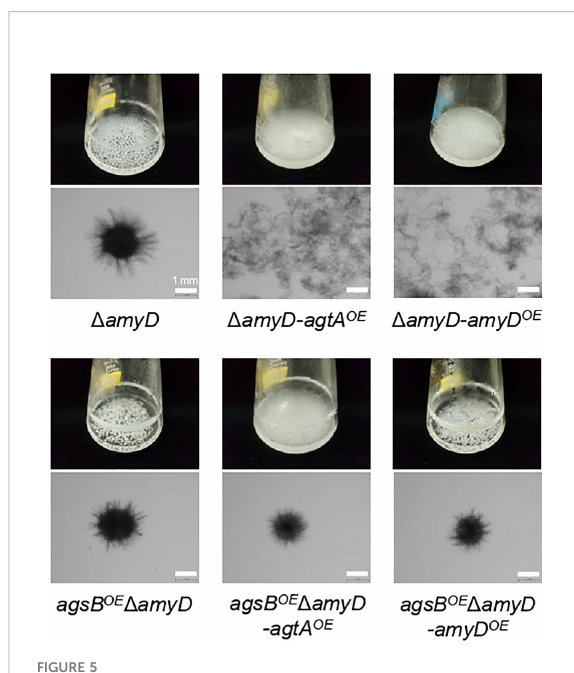
FIGURE 5 Growth characteristics of agtA OE strains of A. nidulans in submerged culture. Conidia (5 × 10 5 /mL) of each strain were inoculated into 50 mL of standard Czapex – Dox (CD) medium and rotated at 160 rpm at 37°C for 24 h. Upper images, cultures in Erlenmeyer fl asks; lower images, representative hyphae under a stereomicroscope. Scale bars, 1 mm.